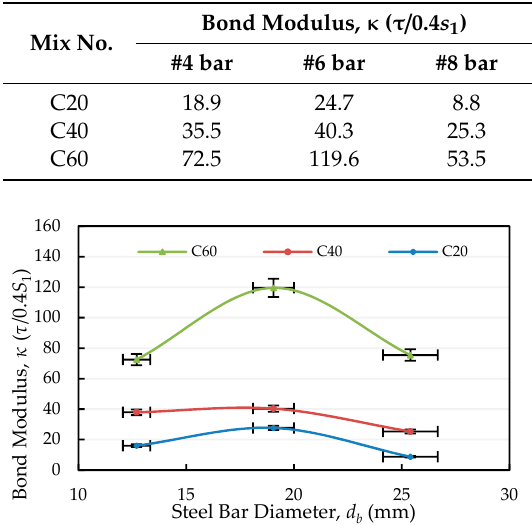
Table 9. Bond modulus for specimens with various bar diameters.